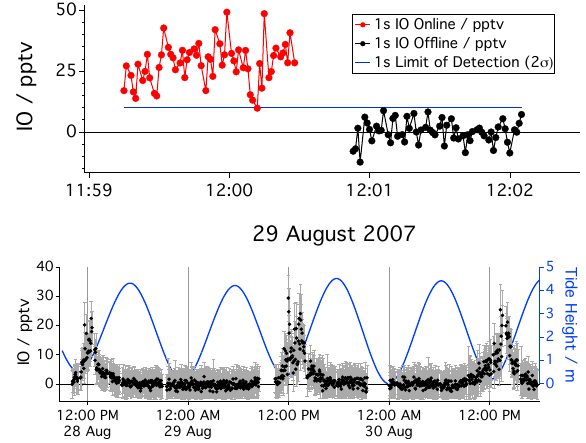
Fig. 4. (top) 1s IO mixing ratio (pptv) (red) at noon on 29 Au- gust (DOY 241) in 2007. The 1s background signal converted to an equivalent IO mixing ratio is indicated as “offline” and shown in black. The 1s limit of detection (2 σ ) shown in blue. Up to 49.7 ( ± 8.6)pptv IO was observed over this short time scale. (bot- tom) 60s IO mixing ratio (pptv; black) with the standard deviation of the 1s data within the 60s block average shown as error bars (grey). Tide height is shown as a blue line.